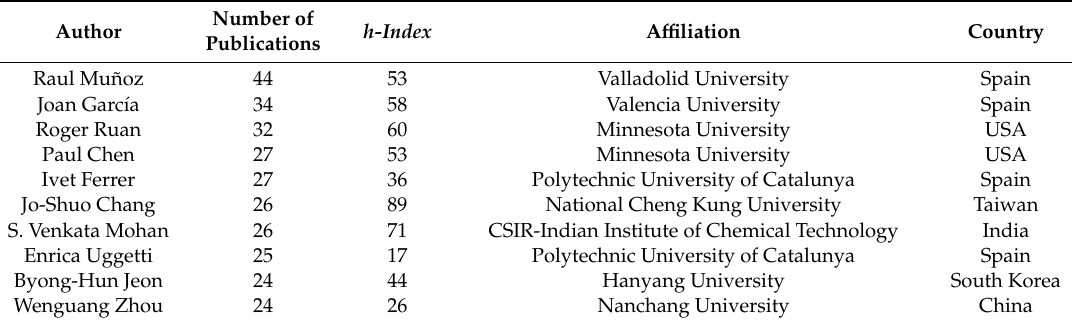
Table 2. Most productive authors between 1981 and 2018.